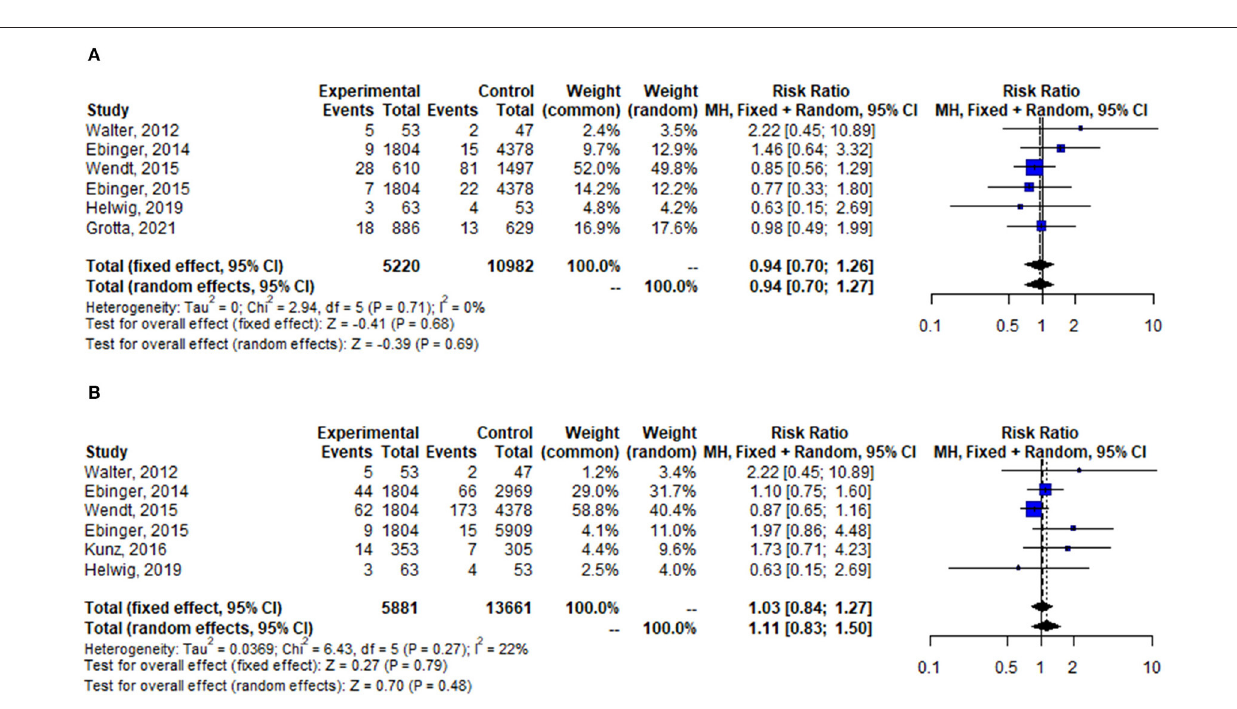
Frontiers in Neurology |